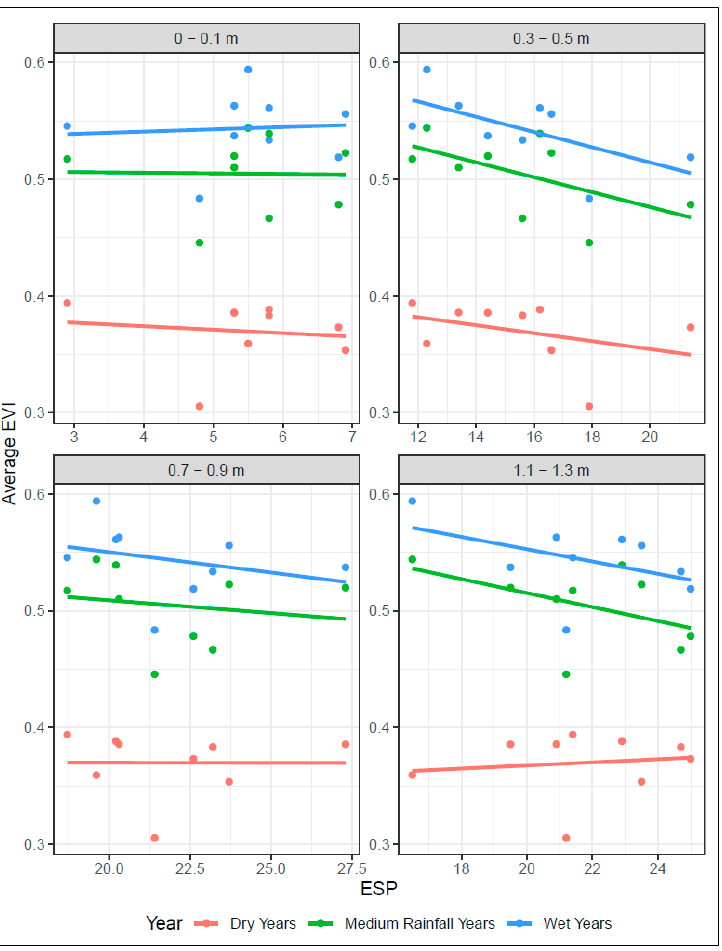
Figure 6. The relationship between average EVI and soil ESP for four soil depths at Field 1 for dry, moderate, and wet years.